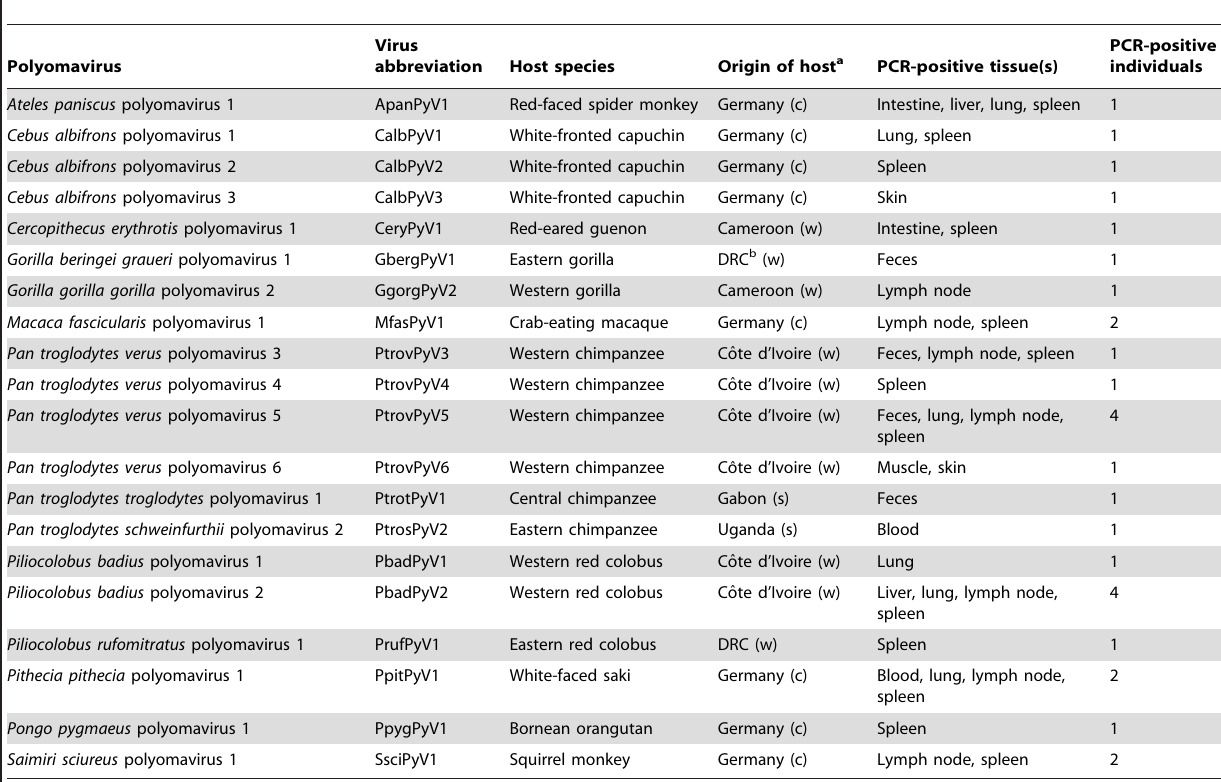
Table 2. Novel polyomaviruses detected in nonhuman primates.